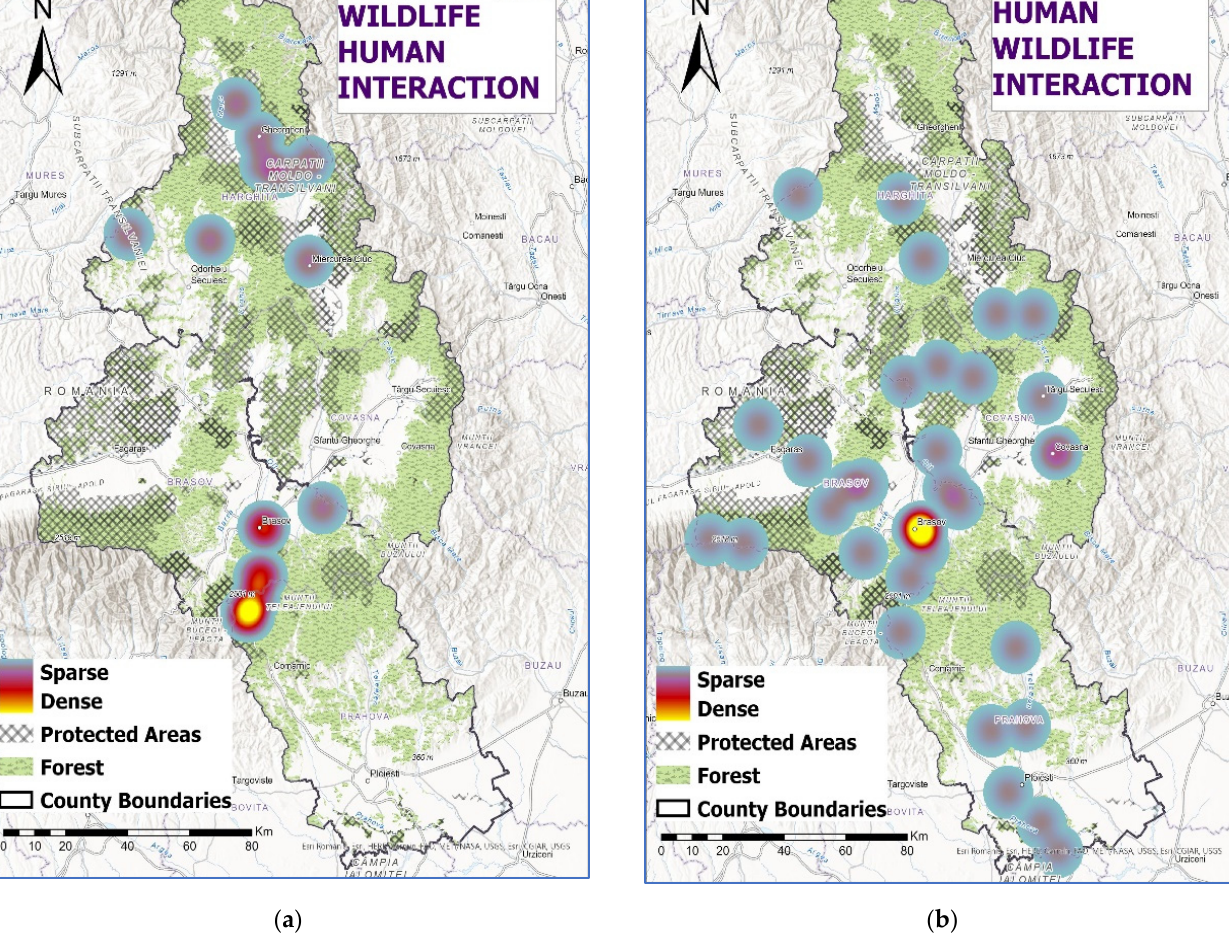
Figure 2. Heatmap of ( a ) WHI and ( b ) HWI.